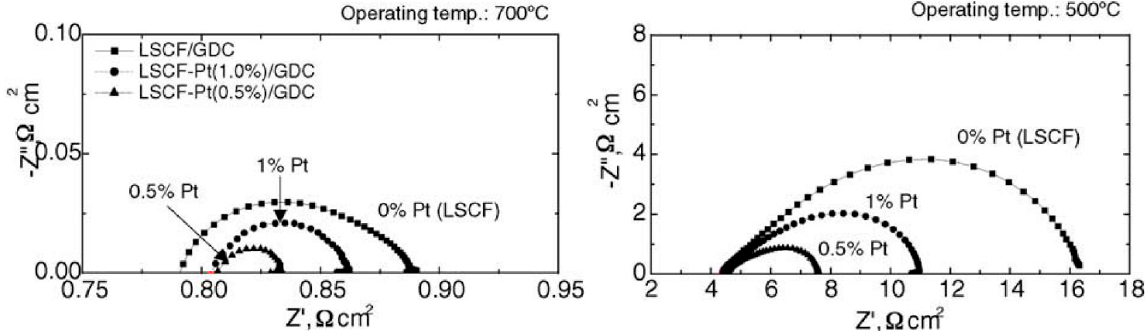
Figure 6. Impedance spectra of LSCF and LSCF-Pt (0.5 and 1 vol %) composite electrodes at 700 °C ( left ) and 500 °C ( right ). (Reprinted with permission from [40], 2005, Elsevier). Cu 2+ ions doped La 0.6 Sr 0.4 Co 0.2 Fe 0.8 O 3− δ cathodes were prepared by Wang and coworkers using